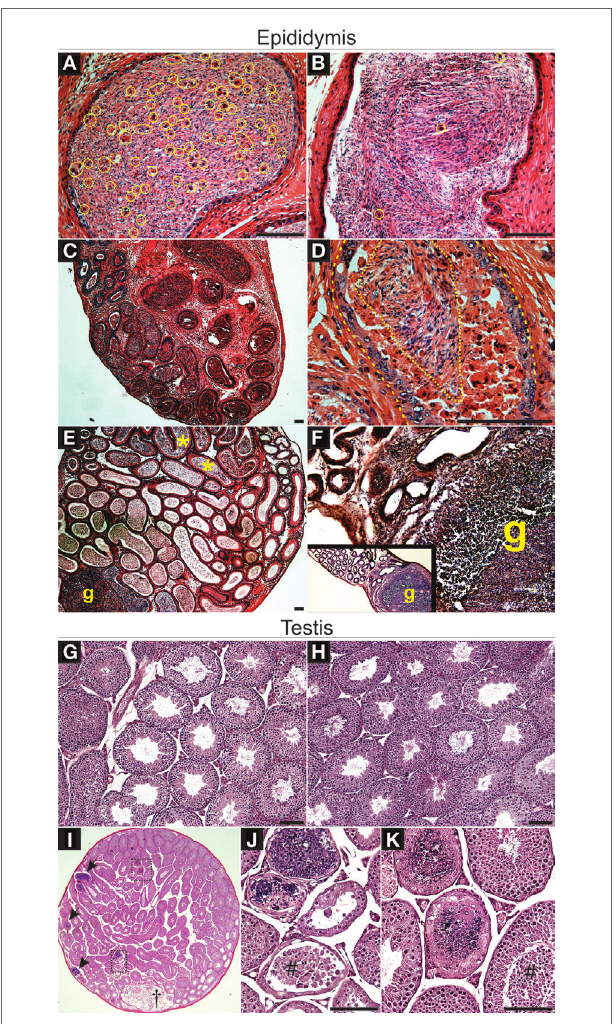
FigUre 1 | Loss of transforming growth factor beta (TGF β )-signaling in dendritic cells (DCs) leads to severe leukocytosis in the adult murine epididymis, as detected by histopathological analyses. (a) Leukocytes (contained in yellow circles or ovals) infiltrated into the luminal compartment of the Tgfbr2 Δ DC cauda epididymis. (B) Control ( Cre − ) cauda epididymis exhibits few somatic cells (yellow circles), as expected. (c) A typical case of severe Tgfbr2 Δ DC epididymal leukocytosis in which leukocytes are abundant both in the periphery of duct profiles and in the luminal space. (D) Large portions of epididymis luminal space were occupied by leukocytes and debris (dashed line indicates duct epithelial lining and dotted line indicates area still occupied mostly by sperm). (e) Epididymal granulomas (g) were detected in 4 of 12 Tgfbr2 Δ DC epididymides analyzed. In addition to granulomas, this particular sample exhibited an apparent duct obstruction as sperm accumulated in initial segment (*). (F) Large sperm granuloma (g) in Tgfbr2 Δ DC corpus epididymis. (g) Control testis. (h) Tgfbr2 Δ DC testes, including in 3 of 4 Tgfbr2 Δ DC males with epididymal granulomas, exhibited no signs of histopathology. (i) Testicular pathology (arrows and rectangular boxes) localized in seminiferous tubules of 1 of 12 Tgfbr2 Δ DC males analyzed. The rete testis (†) appears expanded and contains sperm, isolated non-sperm cells and cell clumps. (J,K) . Boxed areas from panel (i) shown magnified. Tubular histopathology in seminiferous tubules is not concurrent with increased number of interstitial cells (leukocytosis) and seminiferous epithelia detachment appears present (#). N = 12 Tgfbr2 Δ DC males and five control ( Cre − ) littermates at age 8–10 weeks old. Scale bars = 50